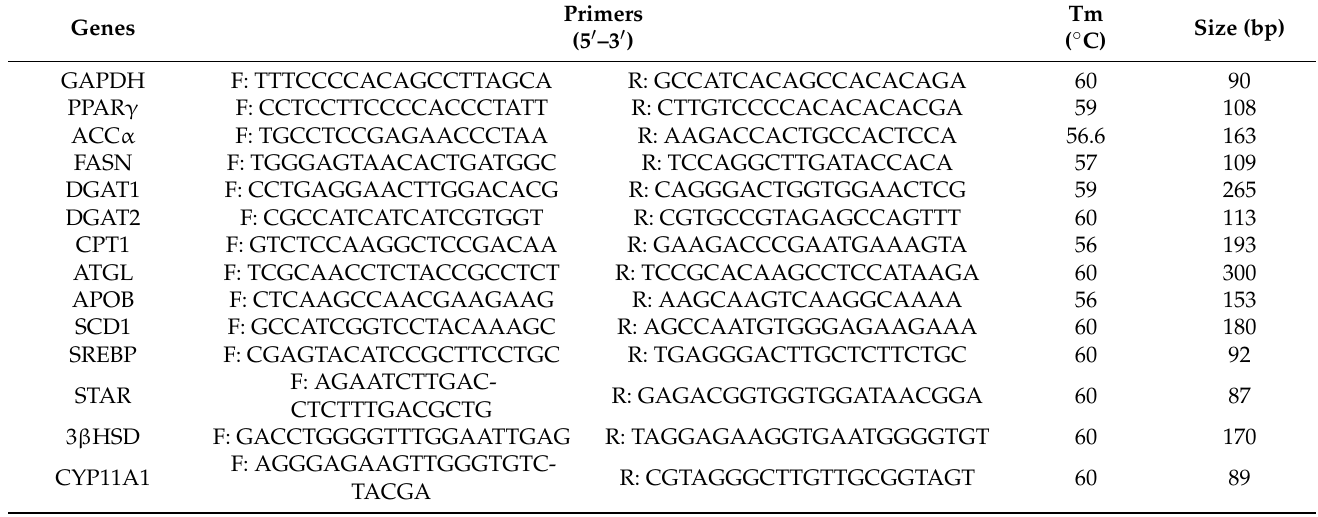
Table 2. Primers for